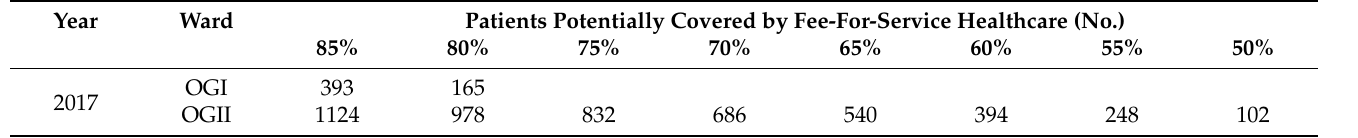
Table 3. Potential patients covered by fee-for-service medical services according to the ward level of